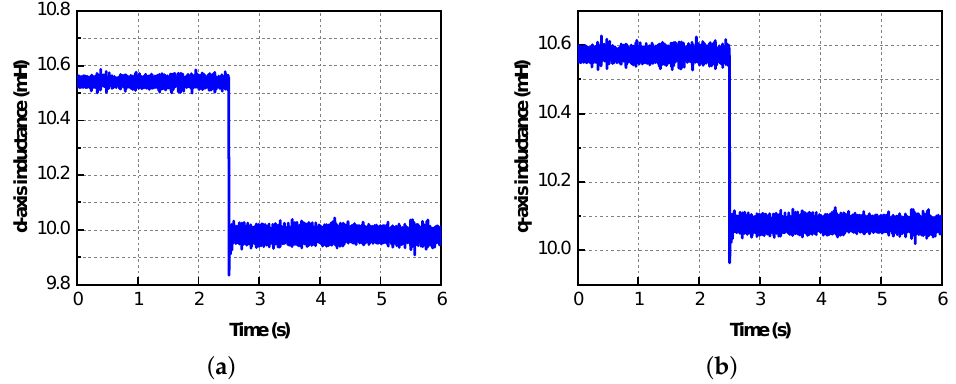
Figure 17. Estimated inductance according to the inductance matrix table. ( a ) d-axis inductance and ( b ) q-axis inductance.